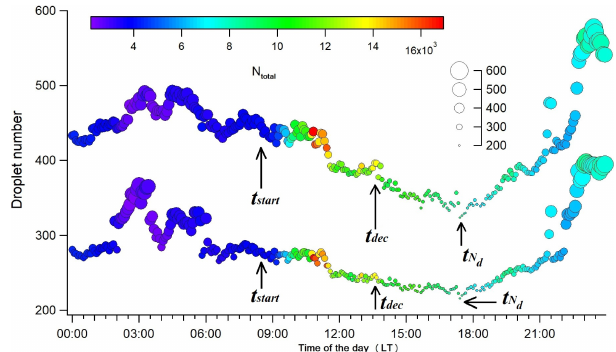
Figure 5. Diurnal evolution of the total aerosol particle number concentrations in cm − 3 ( N total – color bar) and calculated cloud droplet number concentrations ( N d ) (left axis) for updraft veloci- ties of σ w = 0 . 3 (bottom) and σ w = 0 . 6ms − 1 (top) during the “rep- resentative” new particle formation event captured at Finokalia on 29 August 2012. The size of the circles corresponds to the number concentration of N d , while t dec is the “decoupling time” (13:30LT) and t Nd is the time when the number of droplets starts to “feel” the NPF (17:25LT), according to the approach described in the main